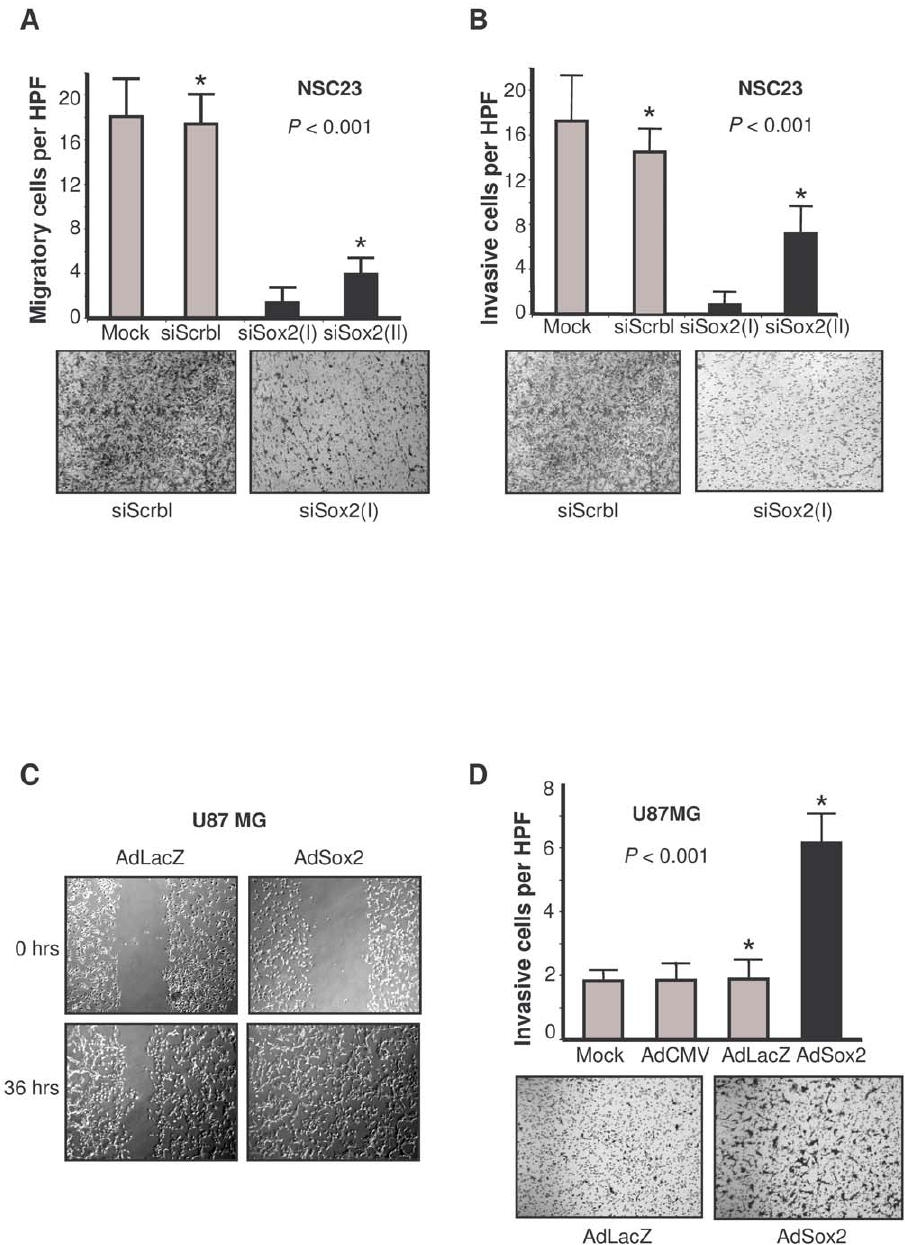
Figure 5. Role of Sox2 in the migration and invasion properties of GBM. A. Assessment of cell migration of Sox2-silenced BTSCs. Sox2 regulates positively the migration ability of BTSCs. For transwell migration assays, NSC23 cells were untreated or transfected with siRNA scramble, siRNA Sox2(I), or siRNA Sox2(II). Quantification of the migration is expressed as the number of migrating cells per high-power field (HPF; 6 40). Bottom, representative micrographs of the transwell migration assay (10 6 magnification). B. Assessment of cell invasion in Sox2-silenced BTSCs by transwell invasion. Sox2 regulates positively the invasion ability of BTSCs. For transwell invasion assays, NSC23 cells were left untreated or transfected with siRNA scramble, siRNA Sox2(I), or siRNA Sox2(II). Quantification of the invasion is expressed as the number of invasive cells per HPF. Bottom, representative micrographs of the transwell invasion assay (10 6 magnification). C. Assessment of migration in Sox2-overexpressing glioma cell lines by wound assay. U-87 MG cells were left untreated or infected with 100 multiplicities of infection (MOIs) of an adenovirus vector containing an empty cassette CMV (AdCMV), an adenovirus carrying LacZ cDNA (AdLacZ), or an adenovirus carrying Sox2 cDNA (AdSox2). Twenty-four hours later, 1 6 10 5 cells were seeded in six-well plates and left until they reached 80% confluency. At that time (0 h), we performed a scratch with a pippette tip, and repopulation of the wound was observed by light microscopy. D. Assessment of invasion in Sox2-overexpressing glioma cell lines by transwell invasion. U-87 MG cells were left untreated or infected with 100 MOIs of an AdCMV, an AdLacZ, or an AdSox2. Invasion using Matrigel-coated transwell was performed as in B. Quantification of the invasion is expressed as the number of invasive cells per HPF. Bottom, representative micrographs of the transwell invasion assay (10 6